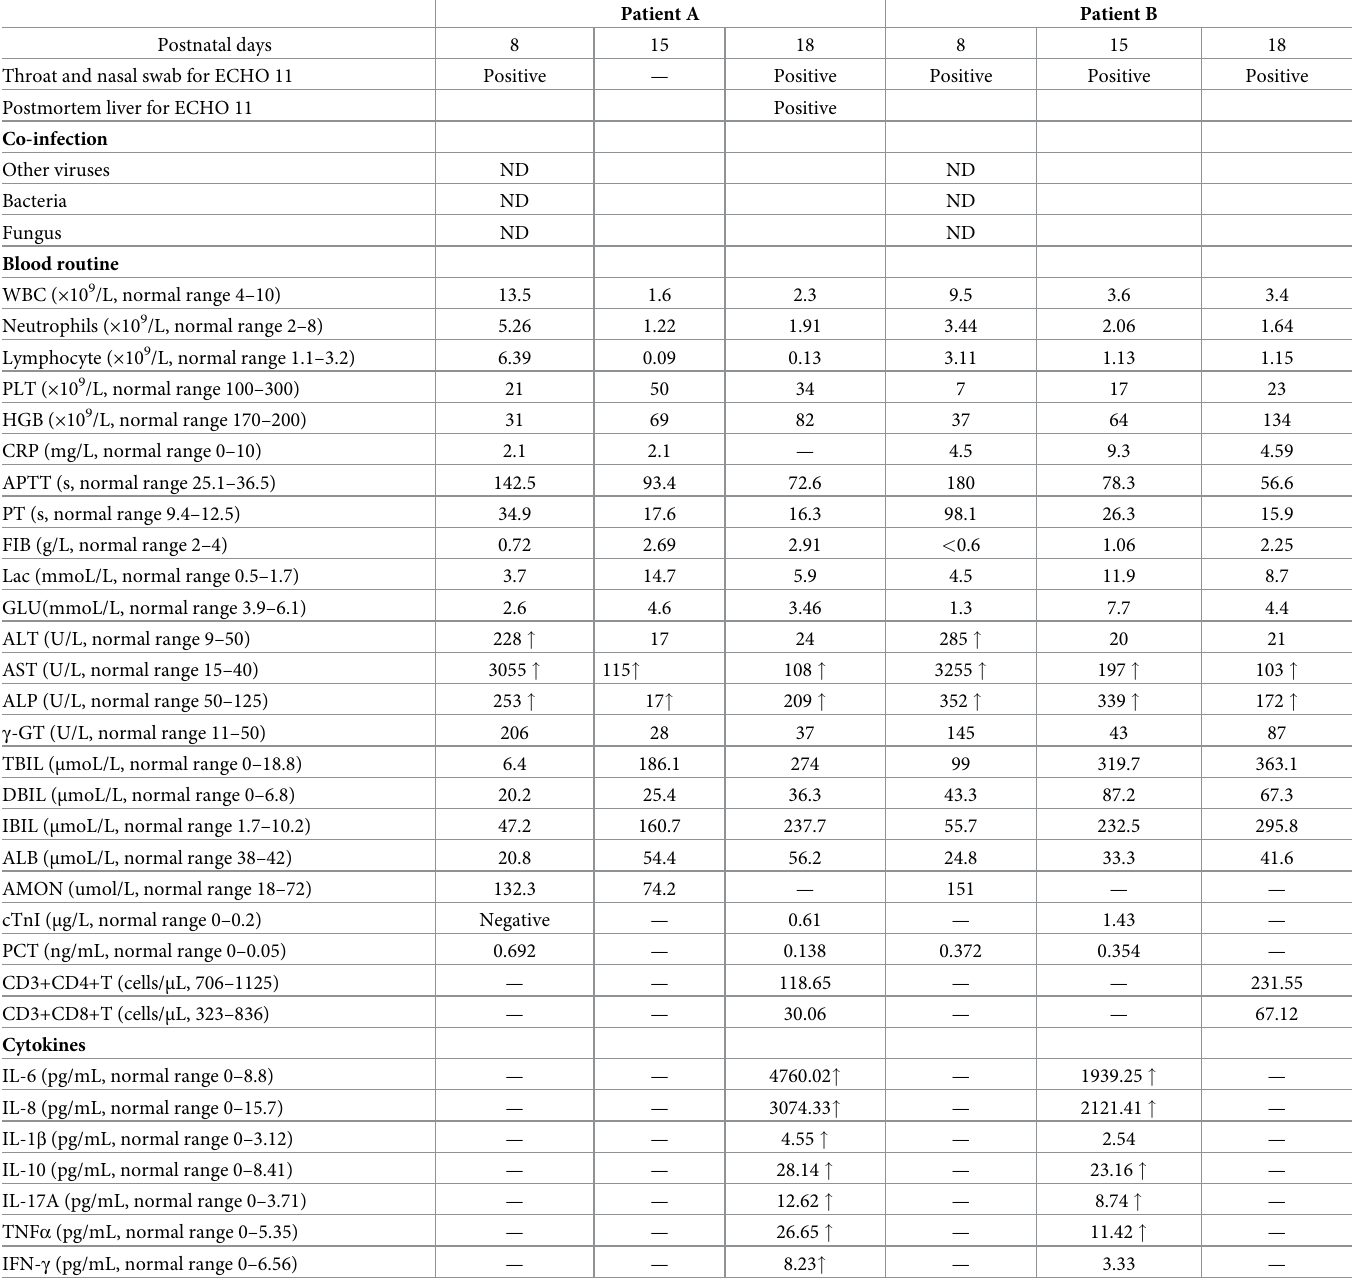
Table 1. Characteristics of newborn patients with ECHO